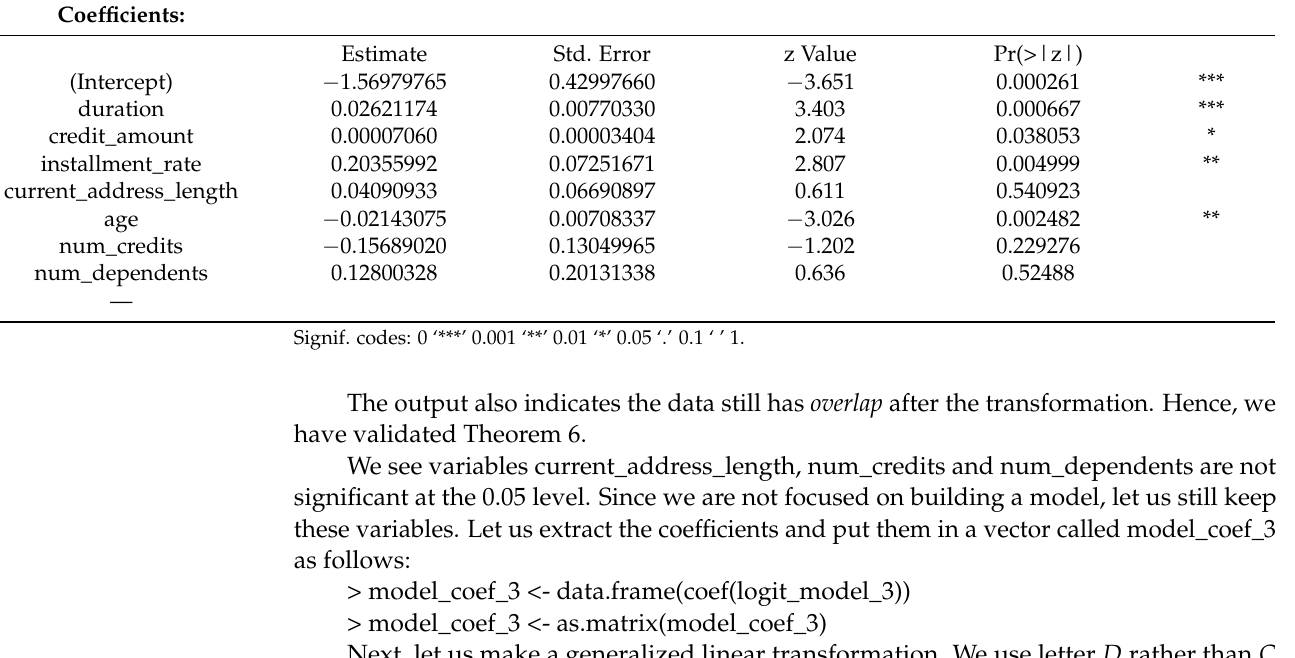
Table 2. Coefficients and statistics for model 3.